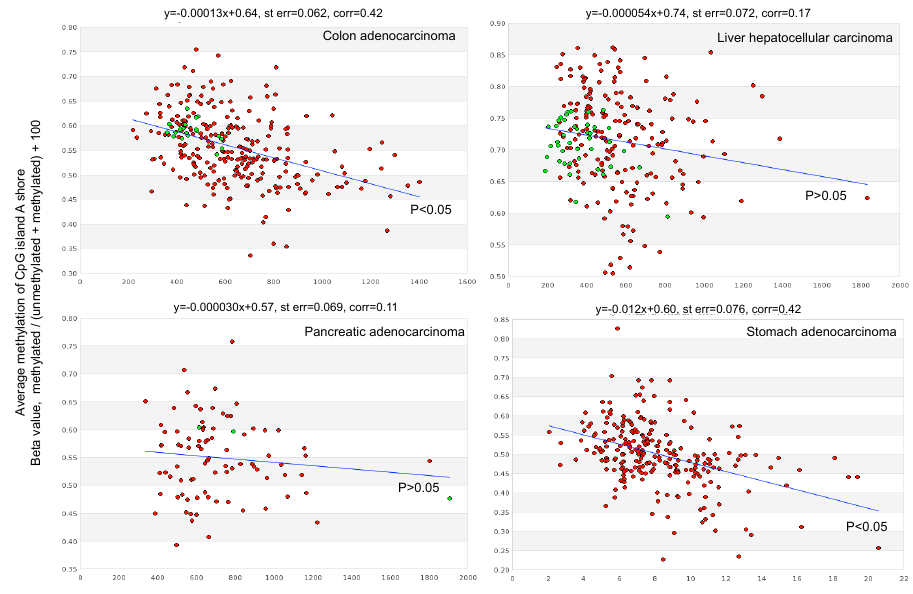
RASSF1A mRNA expression, reads per kilobase per million mapped reads